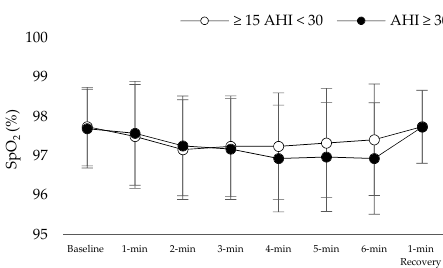
Figure 4. Heart rate (HR) alteration during 6 min walk test.